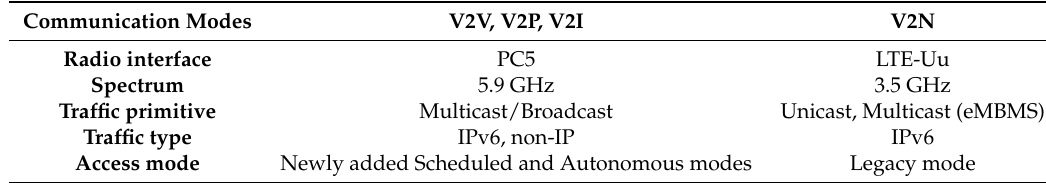
Figure 1. V2X communication modes and main 3GPP V2X-related entities. Table 1. Main features of V2X communication